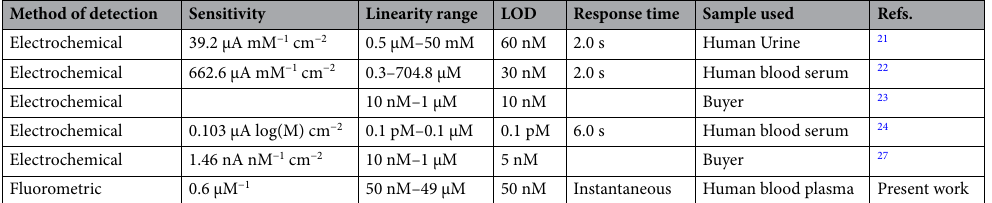
Table 1. A compariso of the fluorometric method used here with previously reported electrochemical